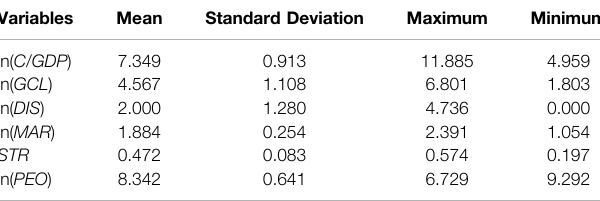
TABLE 1 | Descriptive statistics of variables (provincial level).